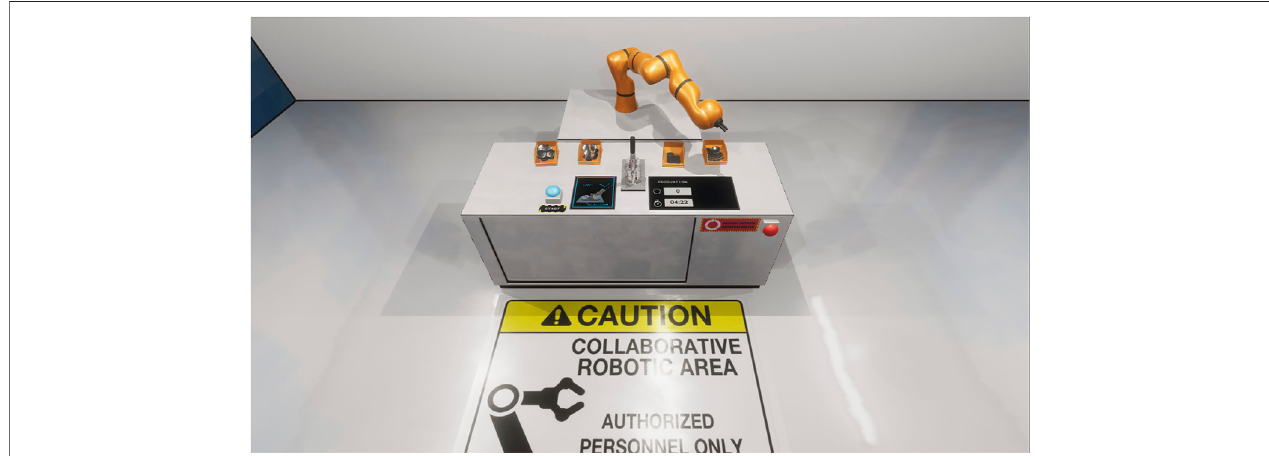
FIGURE 2 | The virtual workplace arrangement at which the participants conducted the shared task in collaboration with the robot arm. Apart from the pin-back button press and the container for the assembly components, the workplace contained a start and emergency shutdown button. Shown is the non-augmented condition where the three communication channels are absent. The virtual workspace where the shared task was executed by the participants in collaboration with the robot arm. The arrangement was designed Note that in the control condition the augmented communication channels are absent.